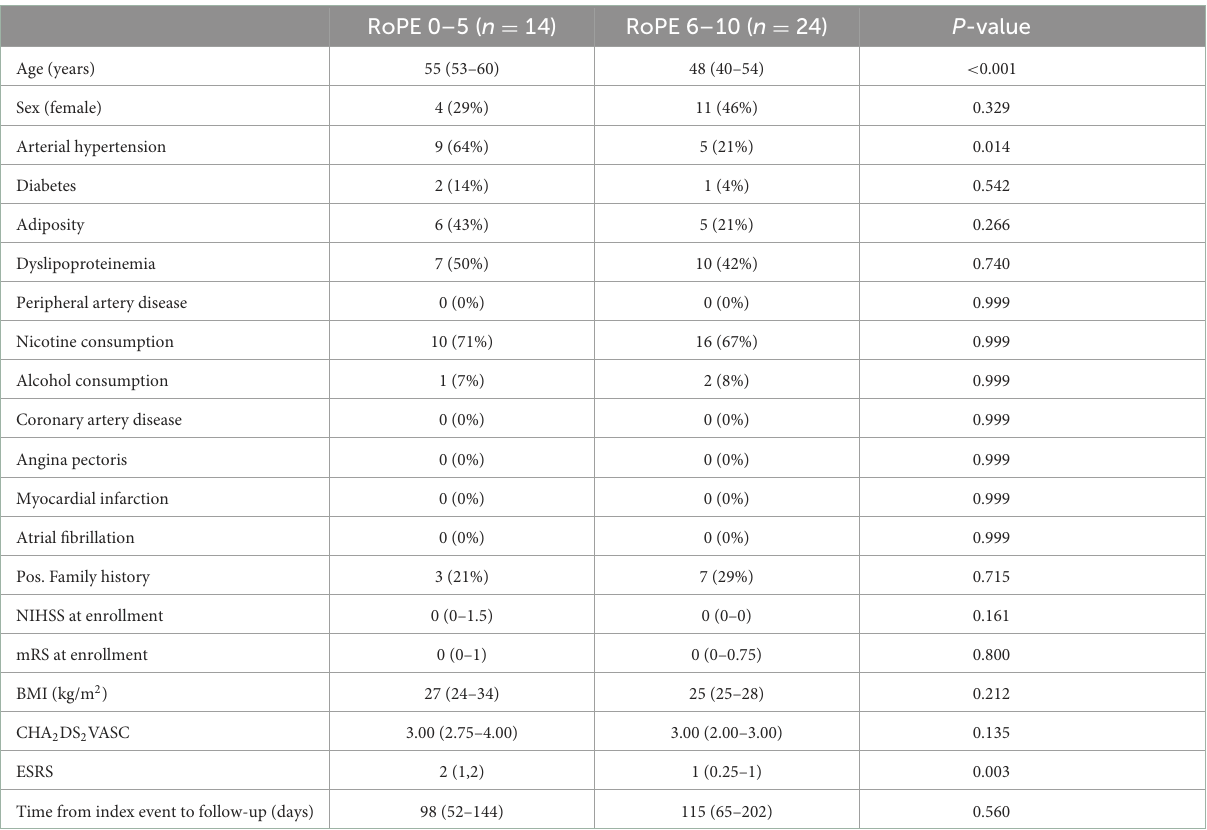
TABLE 2 Clinical and demographical data of cohort